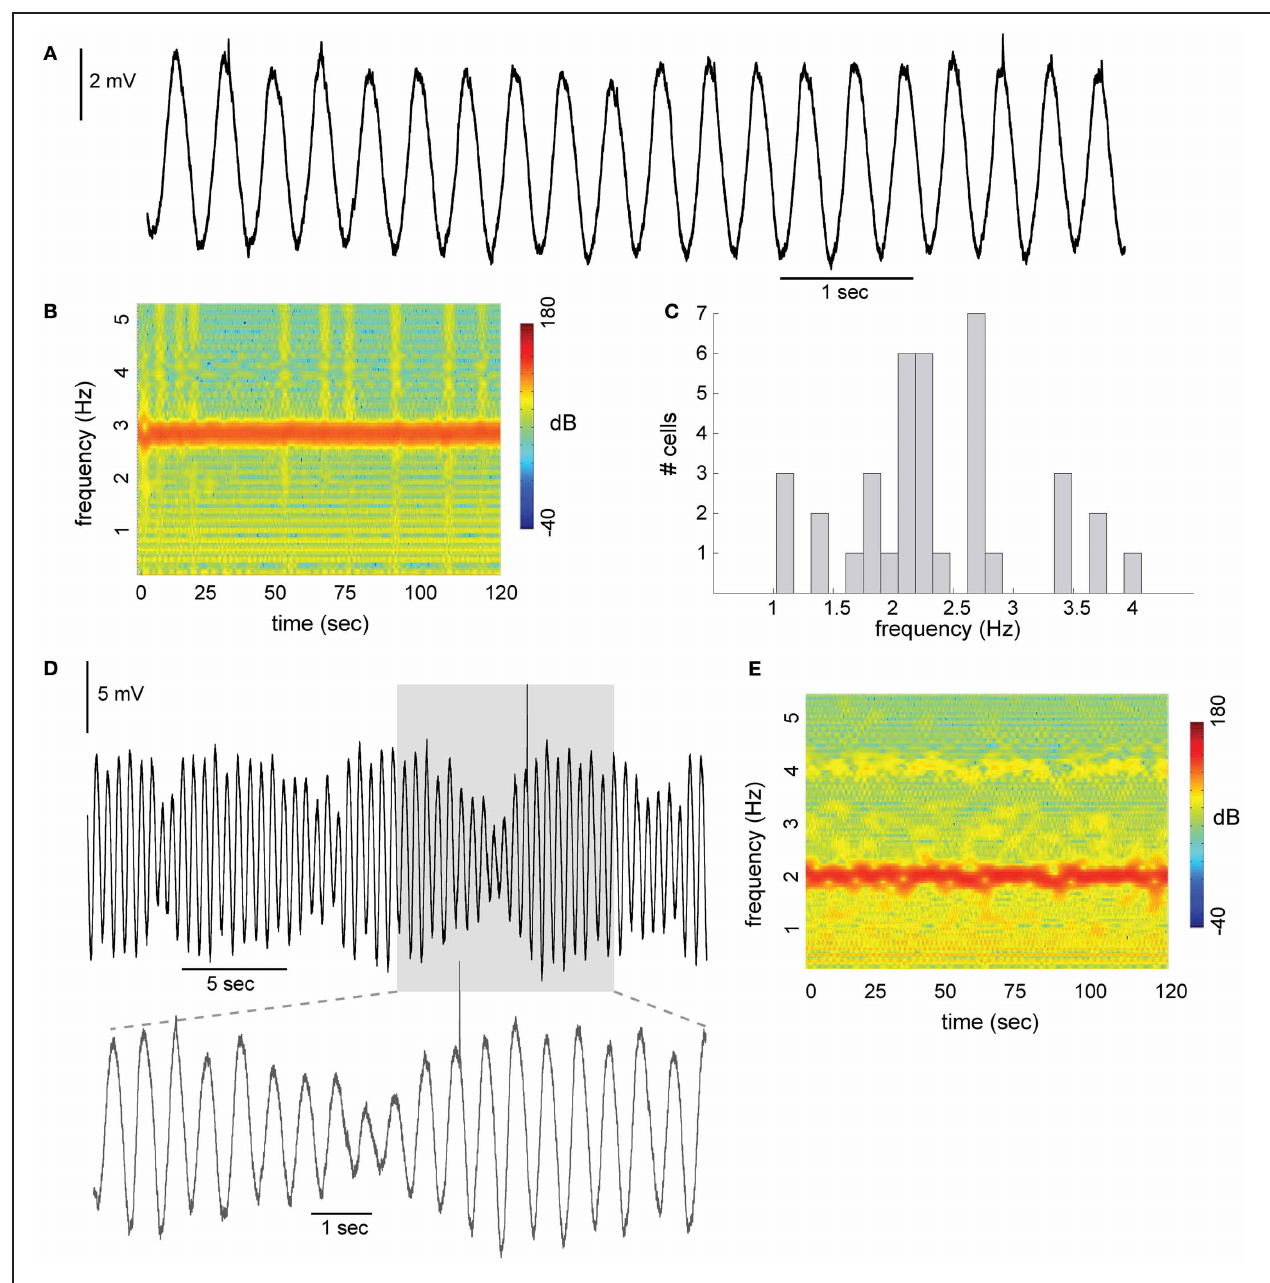
FIGURE 1 | Subthreshold oscillations (STO) in neurons of the inferior olive. (A) Stable sinusoidal like oscillations with constant amplitude recorded from olivary neuron in slice preparation. (B) Spectrogram of the frequency component during 120s of recording. (C) Distribution of STO frequency recorded from 37 olivary neurons.